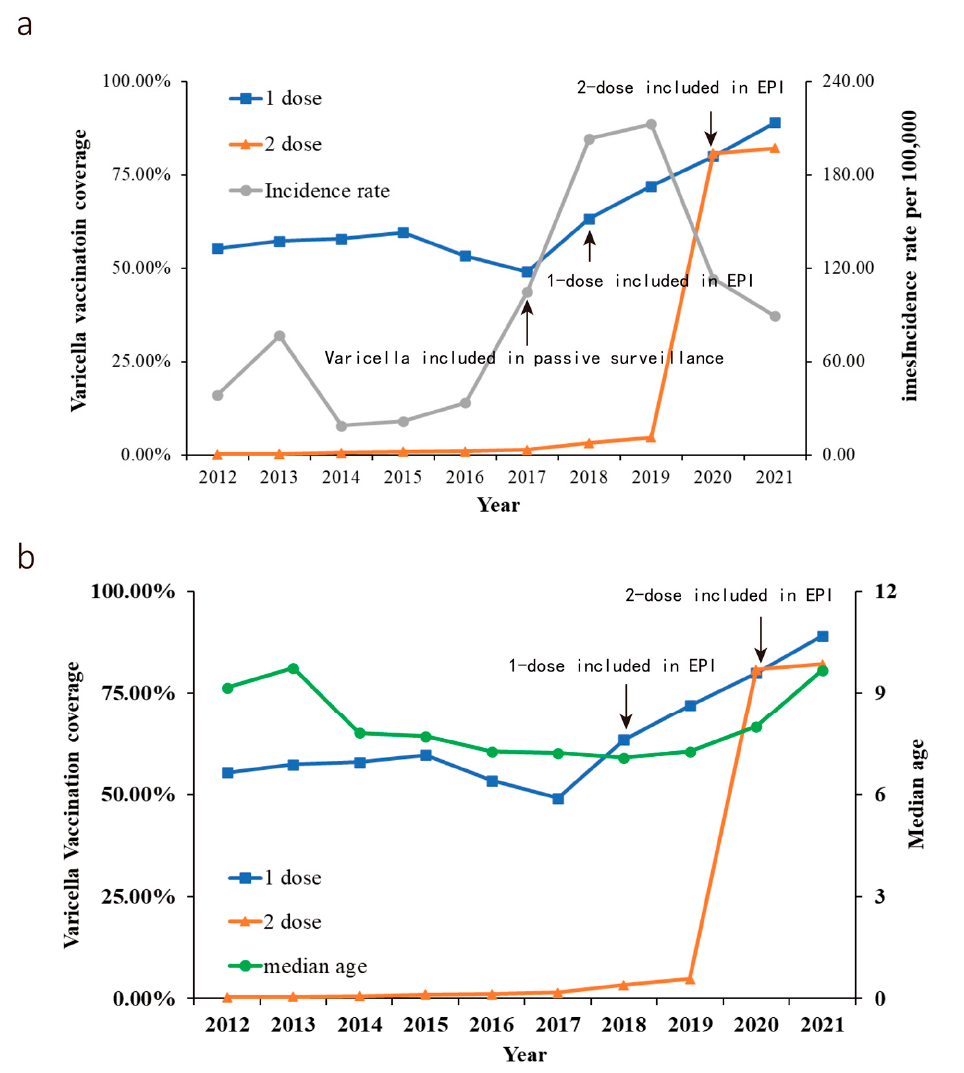
Figure 4. Evaluation of the relationship between vaccine vaccination coverage on varicella incidence or median age in Suzhou, Jiangsu, 2012–2021. ( a ) Change in varicella vaccination coverage and age-specific incidence. ( b ) Change in varicella vaccination coverage and median age.